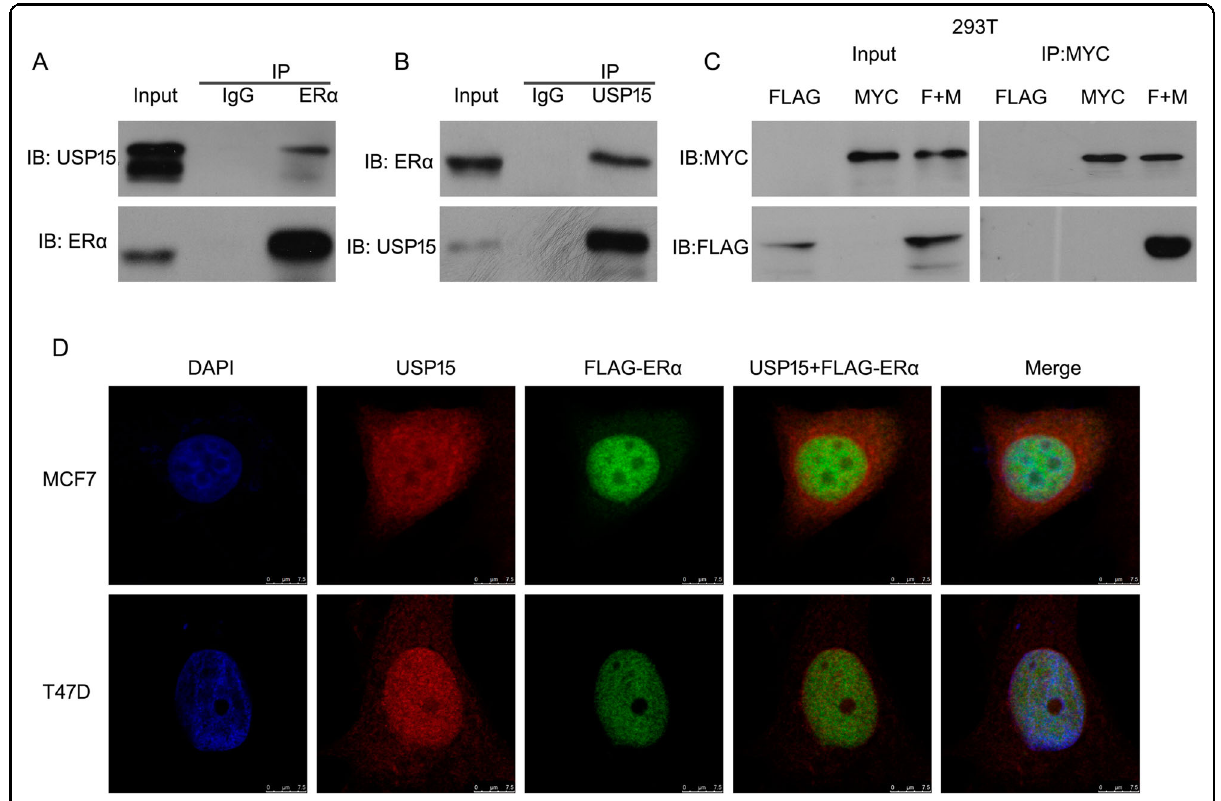
Fig. 4 USP15 interacts with ER α . A , B Proteins were extracted from breast cancer cells. Immunoprecipitated with ER α or USP15, immunoblot with USP15 or ER α . C Proteins from HEK293T cells treated with FLAG-tagged ER α and MYC-tagged USP15. Co-IP and western blot assay were applied for MYC and FLAG. D MCF-7 and T47D cells were treated with FLAG-tagged ER α and then incubated with anti-USP15 and anti-FLAG antibodies. Images were captured by fl uorescence